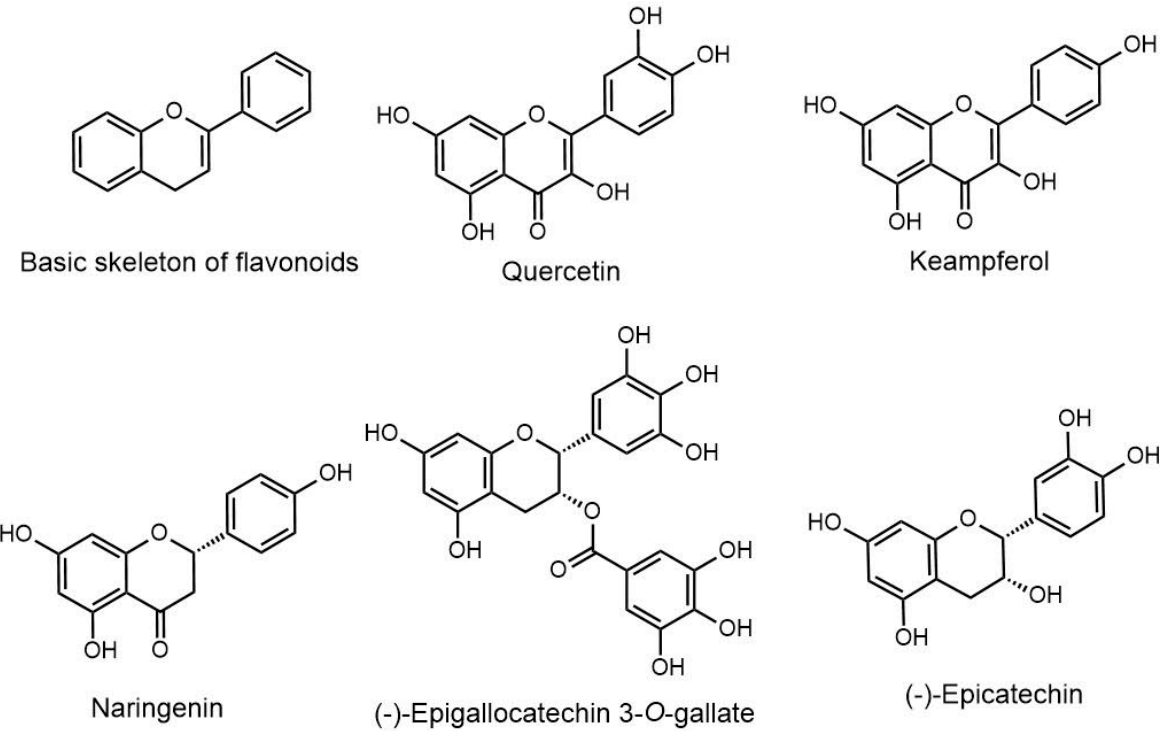
Figure 1. Chemical structures of the di ff erent fl avonoids.